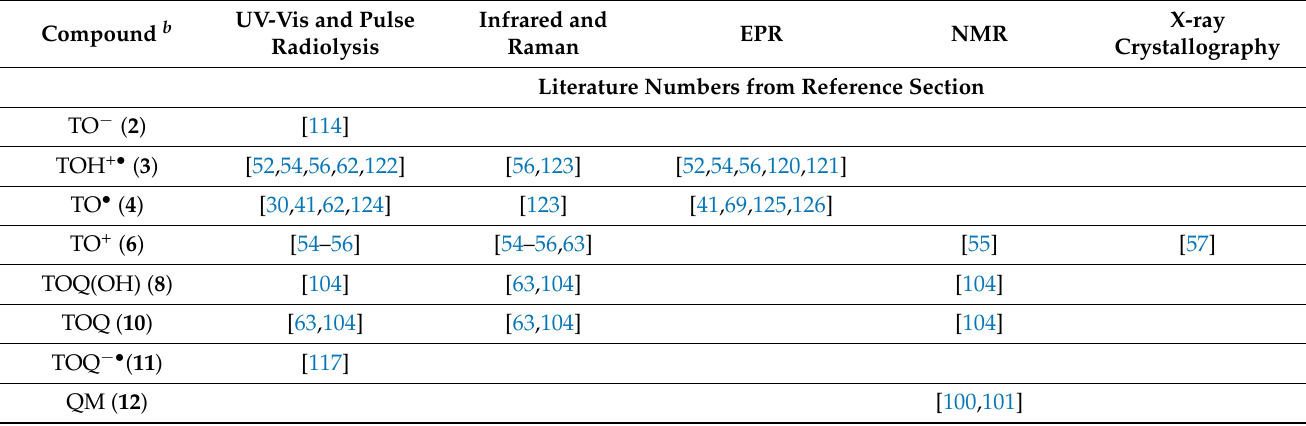
Table 2. Selection of literature reports of spectroscopic data on oxidized forms of vitamin E or is model compounds a